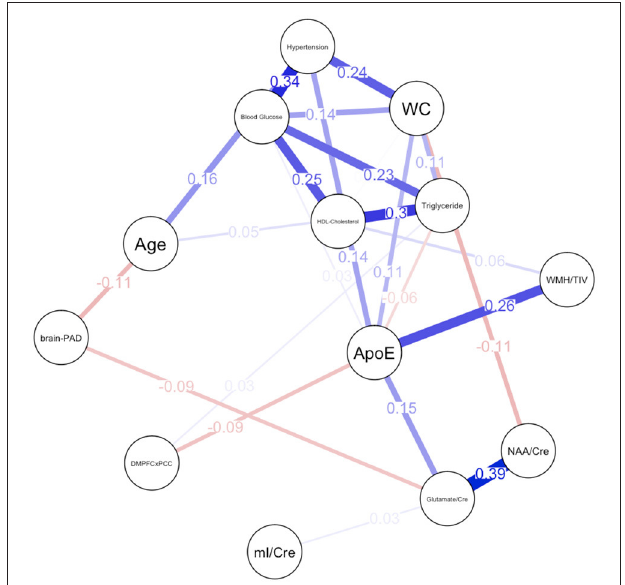
FIGURE 2 | Network plot for females. Brain-PAD, Brain predicted age difference; DMNPFCxPCC, Resting State Functional Connectivity in the Default Mode Network; WC, Waist Circumference; NAA/Cre, Ratio of N-Acetylaspartate to Creatine; mI/Cre, Ratio of Myo-inositol to Creatine; WMH/TIV, White Matter Hyperintensities adjusted for total intracranial volume. Red bars indicate negative correlations and blue bars indicate positive correlations. Thicker, shorter bars indicate stronger relationships. Minimum edge strength set to 0.5 was ignored in network plots because it was larger than the absolute value of the strongest